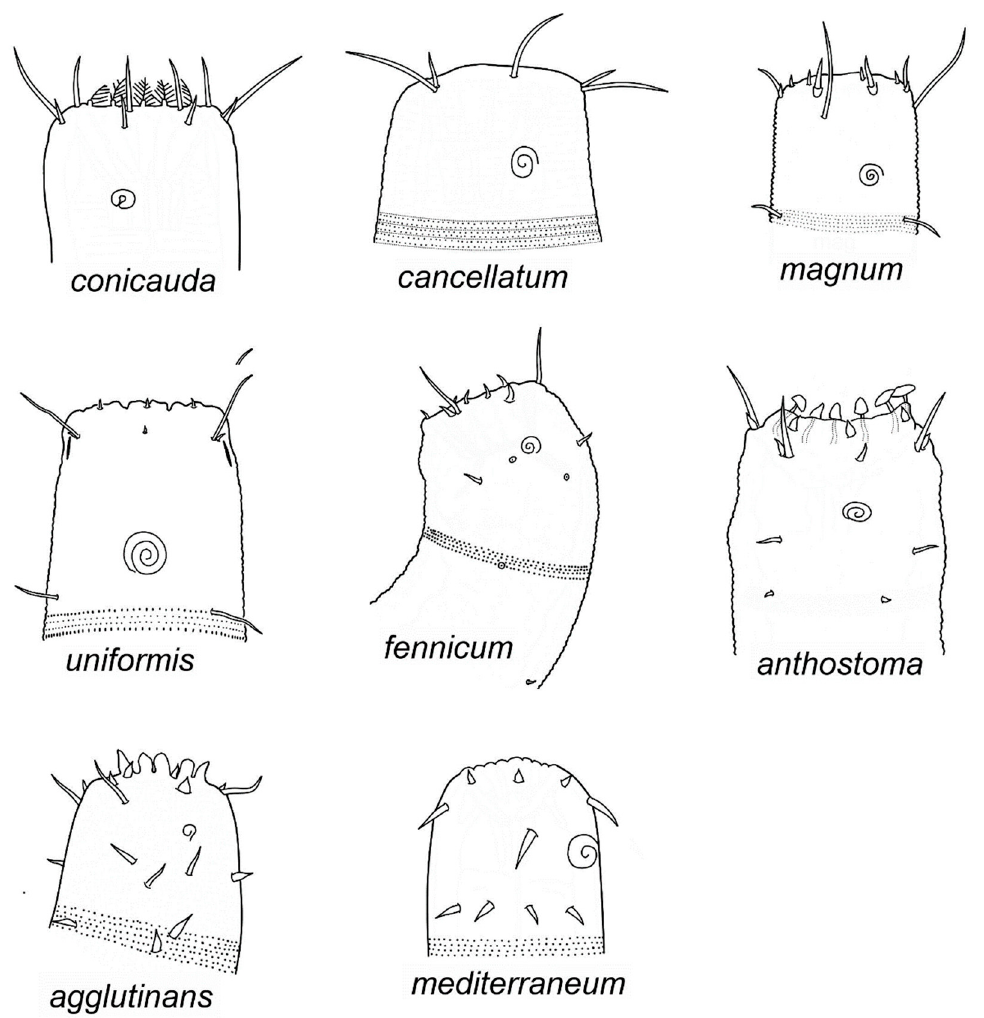
Figure 3. Caricatured female heads of valid Gammanema species arranged from top left to bottom right along decrease of cephalic setae in relation to head